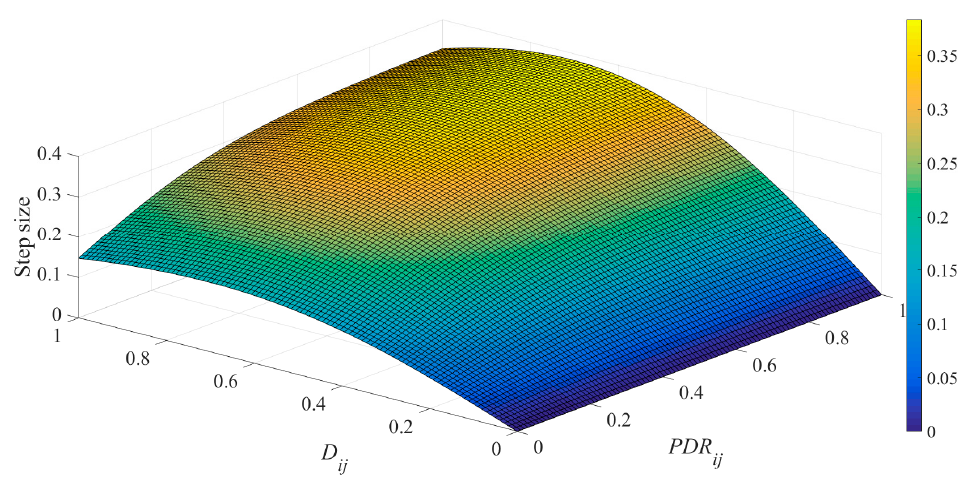
Figure 9. Relationship between step size, distance D ij and power difference ratio PDR ij of the proposed NaFA process.